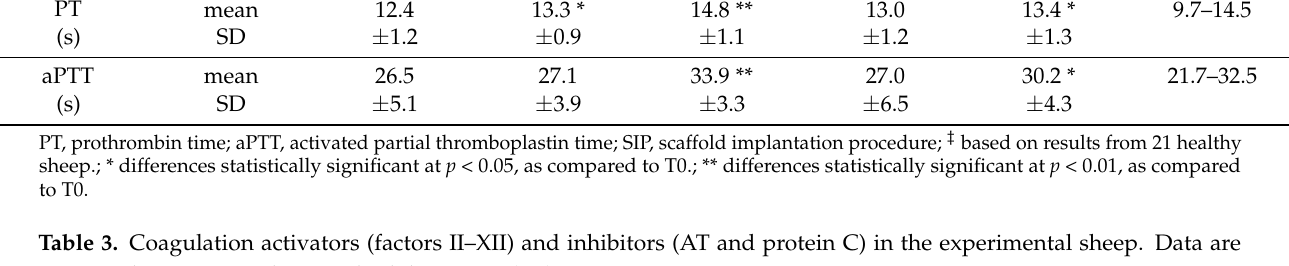
Table 2. Measurements of PT and aPTT in the experimental sheep. Data are expressed as means and ± standard deviations (SD). Assay